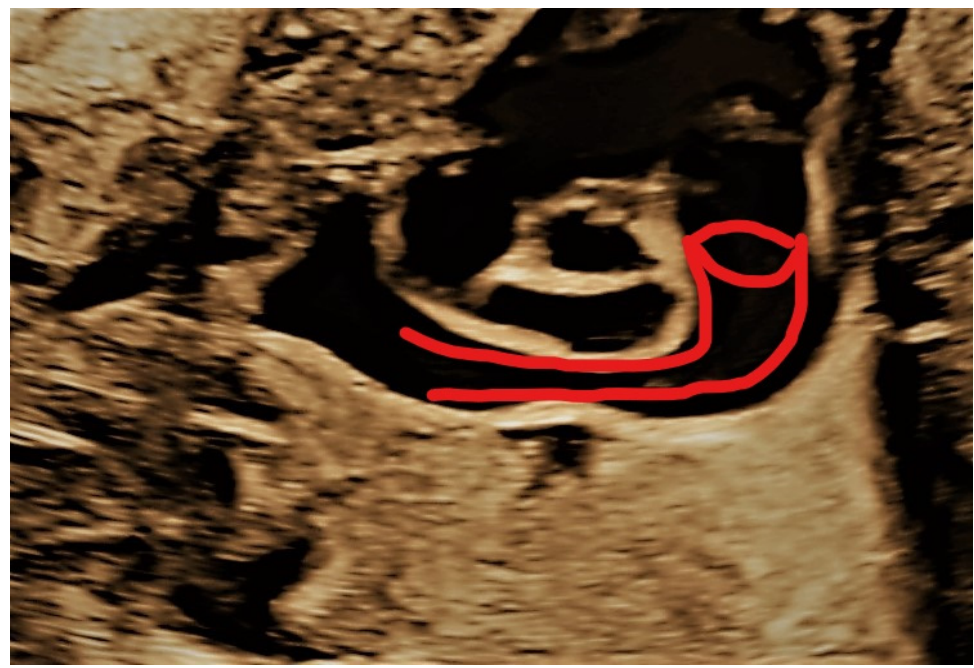
Figure 8. The same case as above; the “pipe sign” sign. Figure 9. The same case as above; the “pipe sign” sign.